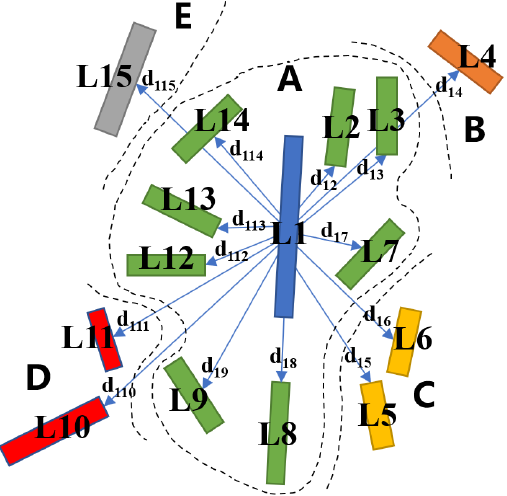
Figure 8. The angle α of a line segment. Figure 7. Neighborhoods of line segments. Figure 7. The angle α of a line segment.